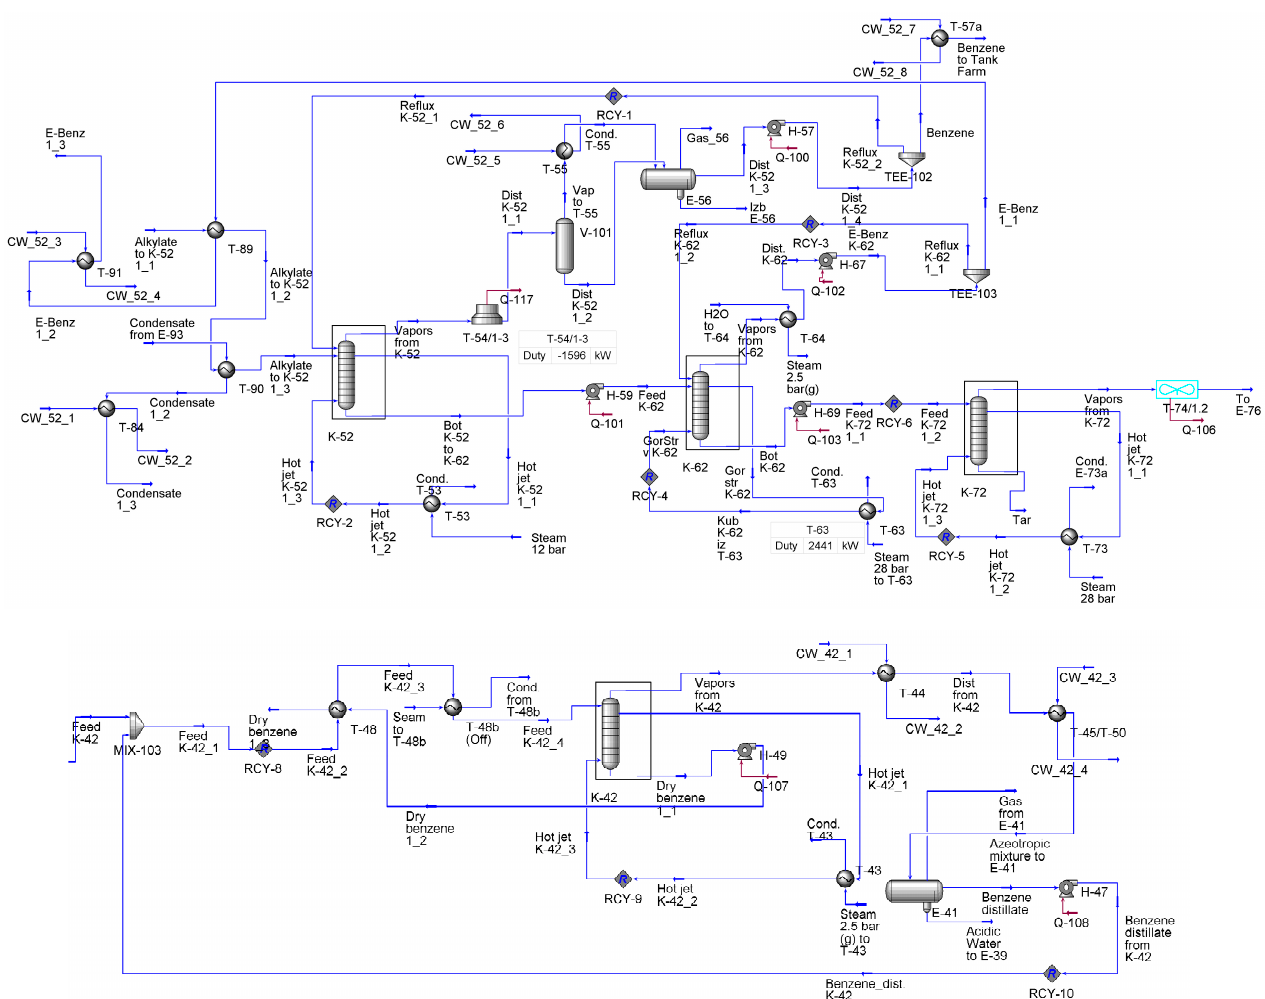
Figure A1. Aspen Hysys model of ethylbenzene production. CW—cool water; K-42—azeotropic drying tower; K-52— recycle benzene stripper; K-62—rectified ethylbenzene recovery column; K-72—column for separating polyalkylbenzenes from tar; Q—compressor; T—heat exchanger.